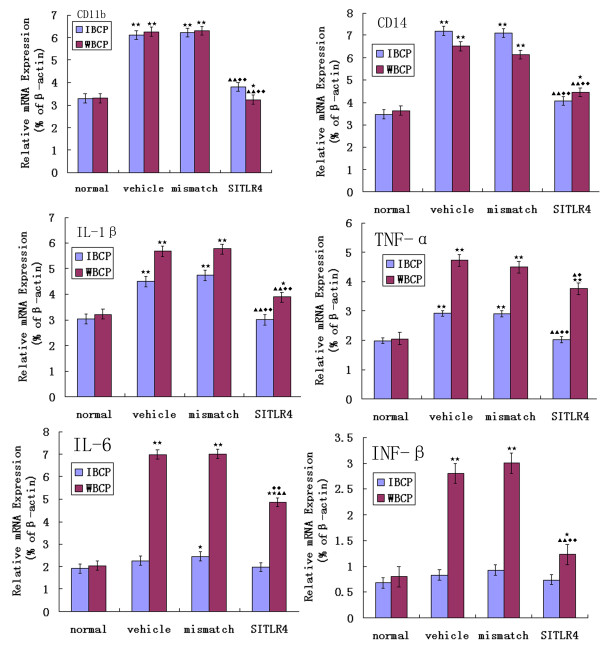
Decreased bone cancer pain-induced microglial activation and proinflammatory cytokine expression by Intrathecal TLR4 siRNA439. In both IBCP group and WBCP group, Real-time quantitative RT-PCR analyses revealed a significant down-regulation of two microglial activation markers, CD14 and CD11b compared with mismatch siRNA- and vehicle-treated rats(n = 4, ANOVA1w, P < 0.01, post hoc Dunnett testing, df = 3, F = 1.08). Proinflammatory cytokines mRNA expression was also significantly down-regulated, i.e., IL-1β (P < 0.01), TNF-α (P < 0.05), IL-6 (P < 0.01), and INF-β (P < 0.01) in the WBCP group; IL-1β (P < 0.01), and TNF-α (P < 0.01) in the IBCP group compared with rats treated with vehicle or the mismatch siRNA. Values are presented as mean ± SEM. *P < 0.05, **P < 0.01 vs. normal group; ▲ P < 0.05, ▲▲ P < 0.01 vs. vehicle-treated group; ◆P < 0.05, ◆◆P < 0.01 vs. mismatch siRNA-treated group.